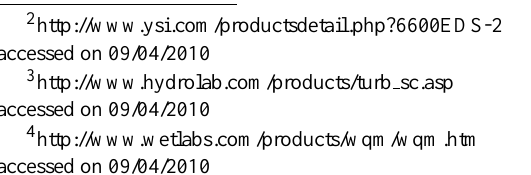
development on the optics Fig. 3. Drift of an unprotected fluorometer due to biofouling devel- An increase of the sensor response due to biofouling is quite particular to fluorescence opment on the optics sensors, usually the drift observed due to biofouling is a decrease in the response. This